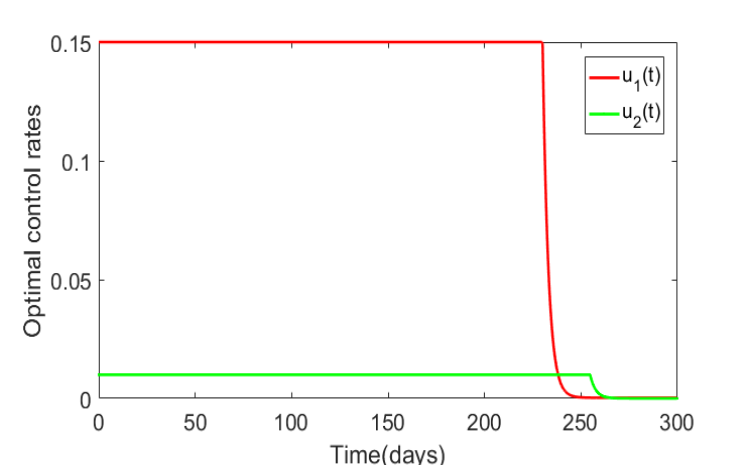
Figure 5. Numerical results illustrating the impact of the bounds for the control rates. The initial guess for the control were u 1 = 0.15 and u 2 = 0.01, the upper bounds of the controls were q 1 = 0.15 and q 2 = 0.01. The weights constants were set to w 1 = 10 and w 2 = 100 and the rest of the model parameter values were as in Table 1.